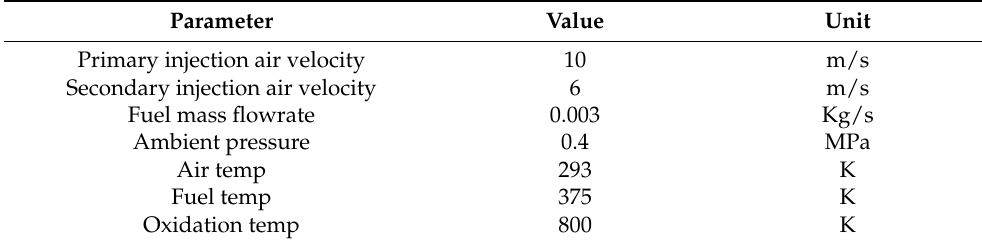
Table 2. Input parameters used for the combustion simulation.